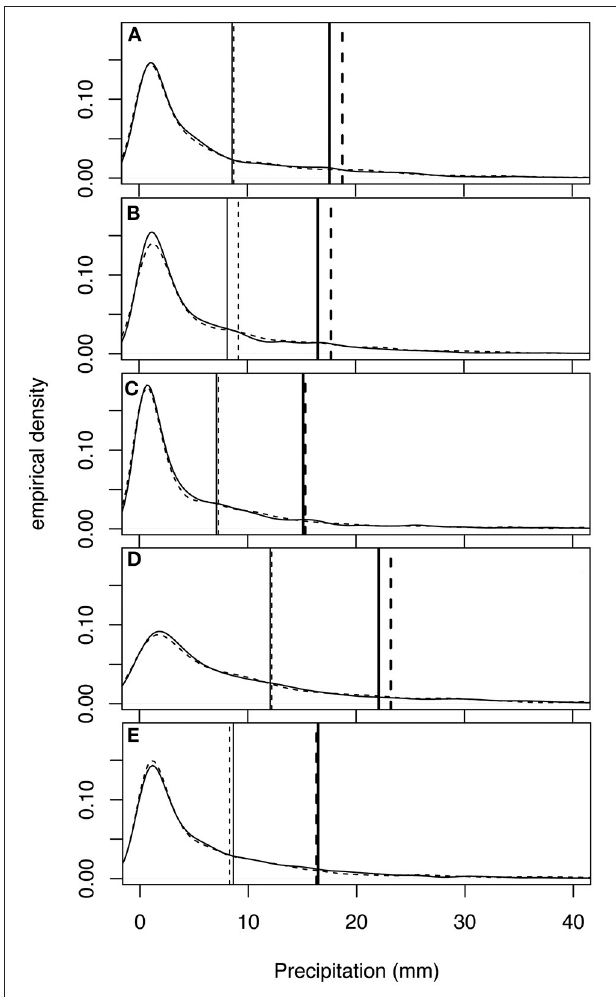
FIGURE 12 | Daily precipitation empirical density functions. The solid black line is the historic bias corrected data and the dashed line represents the future bias corrected data at each location. The dashed vertical lines represent the 75th and 90th (bold) percentile values for the future data and the solid vertical lines represent the 75th and 90th (bold) percentiles values for the historical data at location (A) 200146 (Gratiot, IV), (B) 202423 (Oscoda, I), (C) 205434 (Midland, II), (D) 205662 (Mount Pleasant, III) and (E) 206300 (Owosso,